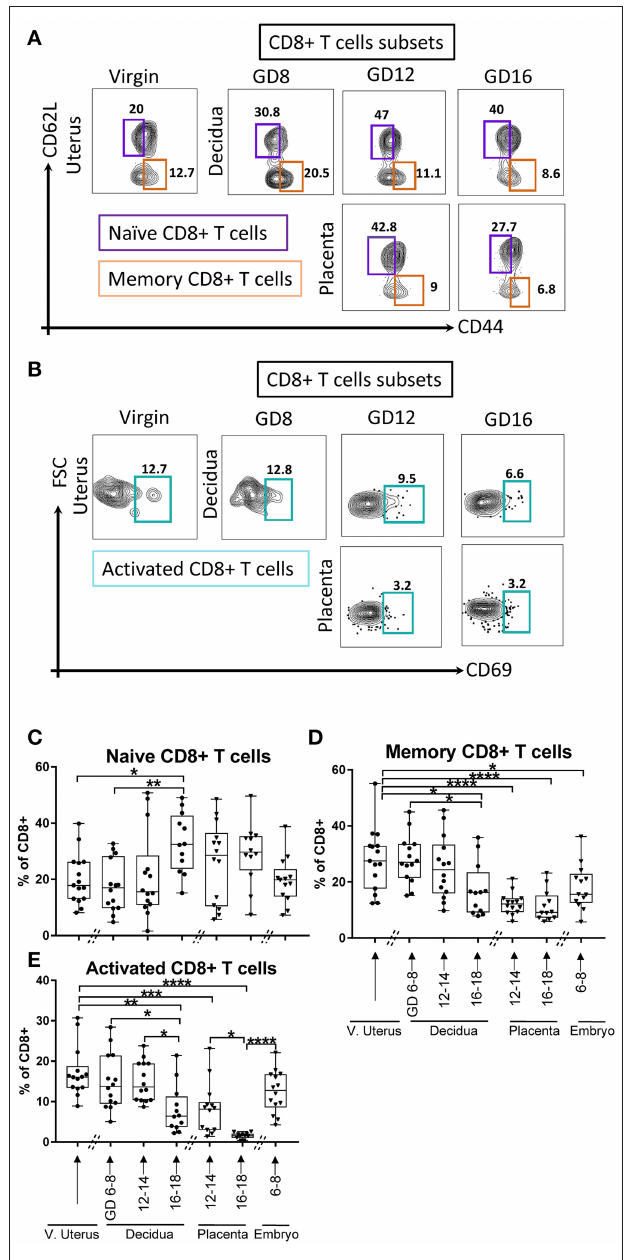
FIGURE 5 | Gating strategy and dynamic change of CD8 + T cells subsets. (A) Gating strategy of Naïve CD8 + T cells, defined as lin2- (Ly6G neg B220 neg I-A/I-E neg ) TCR β + CD8 + CD62L + CD44 neg , and memory CD8 + T cells, defined as lin2-(Ly6G neg B220 neg I-A/I-E neg ) TCR β + CD8 + CD62L neg CD44 + . (B) Gating strategy of activated CD8 + T cells, defined as lin2-(Ly6G neg B220 neg I-A/I-E neg ) TCR β + CD8 + CD69 + . (C–E) Proportions of Naïve CD8 + T cells, memory CD8 + T cells, and activated CD8 + T cells in murine virgin uterus, decidua, placenta, and embryo across gestational age. n = 11–15 (15 independent experiments), the exact number of animals was summarized in Supplementary Table 3 . The data of virgin uterus were compared with decidua group or placenta (include embryo) group, respectively. Statistical analysis was performed using ANOVA followed by post-hoc Tukey analysis. * p < 0.05, ** p < 0.005, *** p < 0.0005, **** p < 0.0001.